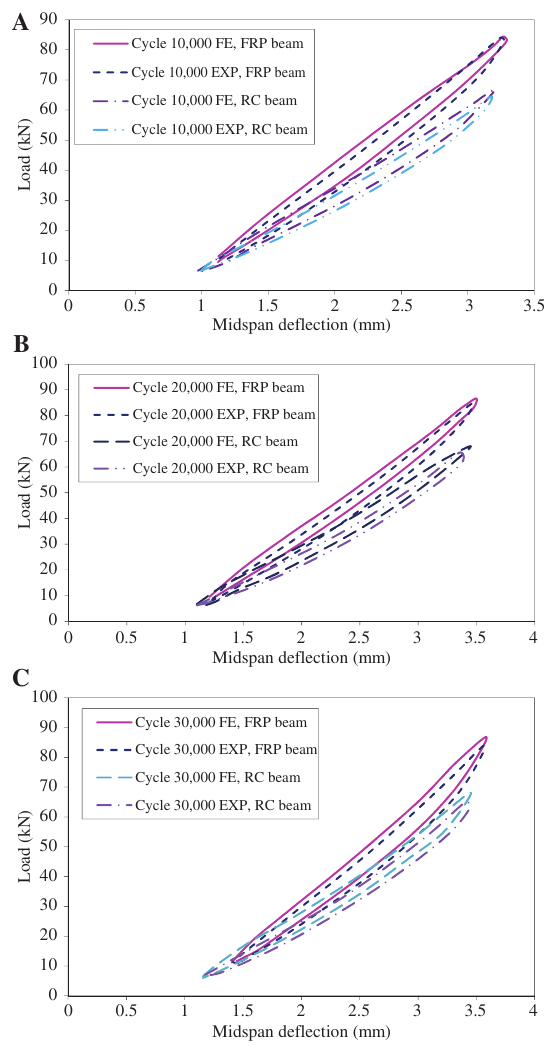
Figure 9: Load-deflection curves of RC and CFRP-retrofitted RC specimens. as determined by FE and experimental